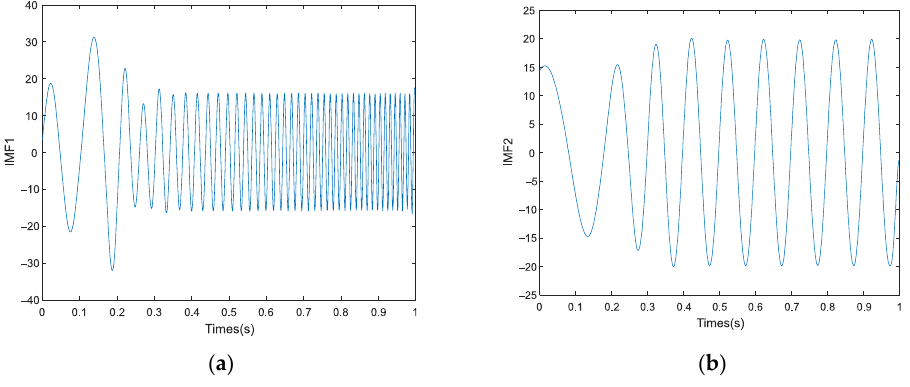
Figure 14. Performance of prediction under the EMD: ( a ) IMF1; ( b ) IMF2.